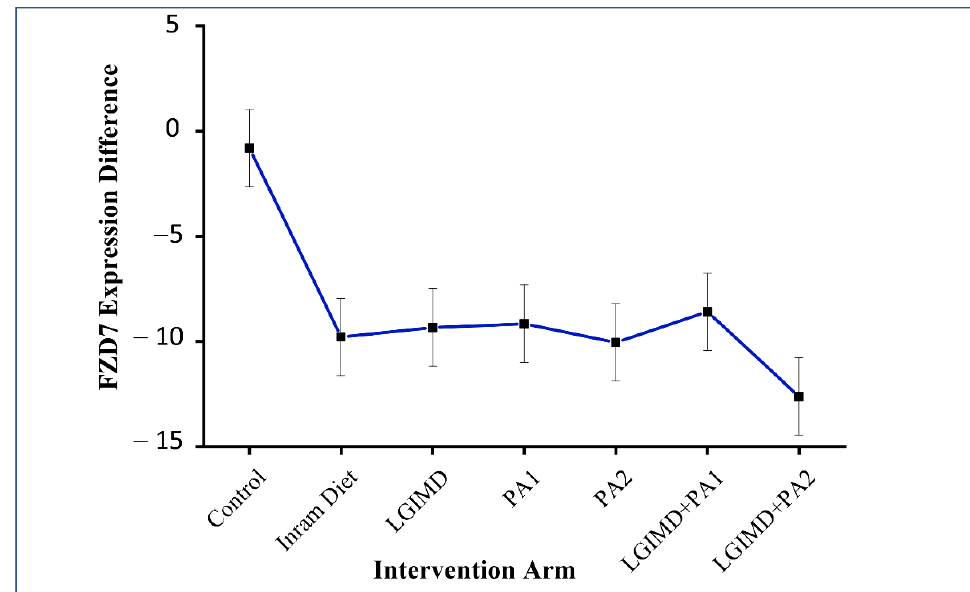
Figure 4. FDZ 7 expression and intervention arm: contrasts and 95% CI. The control group consisted of 20 subjects, the Inram diet group consisted of 16 subjects, the LGIMD group consisted of 17 subjects, the PA1 group consisted of 16 subjects, the PA2 group consisted of 14 subjects, the LGIMD + PA1 group consisted of 16 subjects, and the LGIMP + PA2 group consisted of 16 subjects.